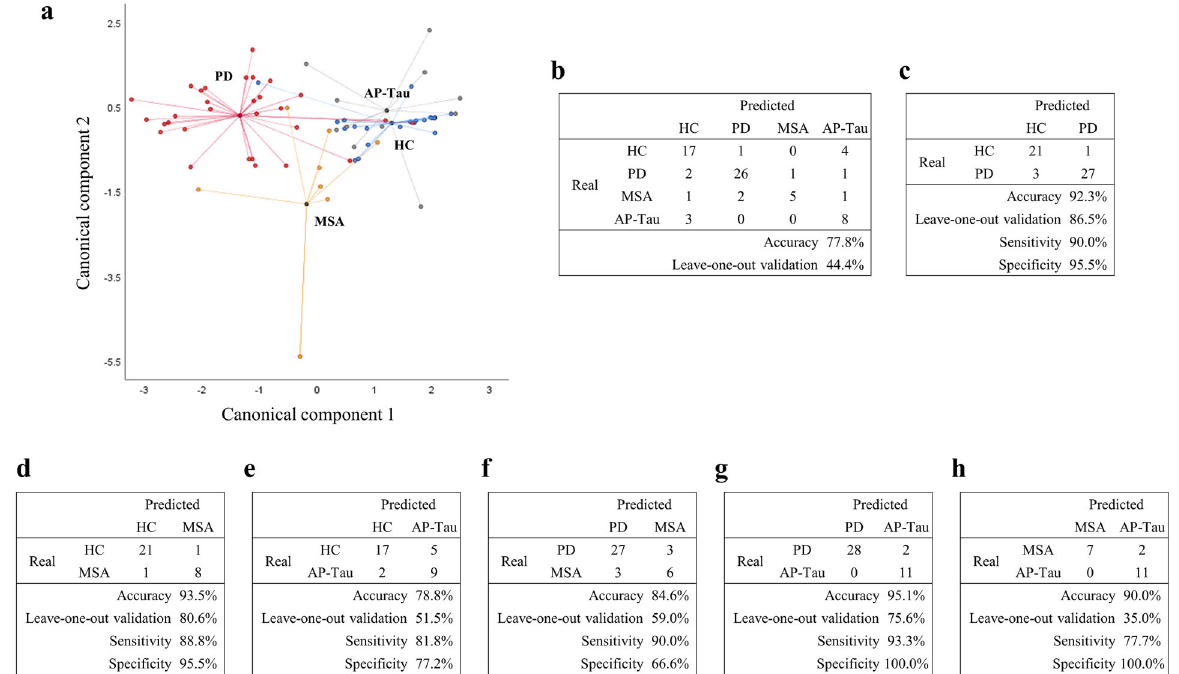
Fig. 6 Skin biopsy-derived compound marker allows strati fi cation of patients according to the diagnosis. a Canonical plot showing patients according to the diagnosis. The model was built considering the presence/absence of α Syn-PLA, P- α Syn, α Syn-5G4, and intraepidermal nerve fi ber density (IENFD) at both anatomical sites. The axes of the plot (canonical components 1 and 2) were calculated from weighted linear combinations of variables to maximize the separation between the four groups. Each subject is represented by a point. b – h Confusion matrix reporting real and predicted diagnosis, accuracy, internal validation by the leave-one-out algorithm, sensitivity, and speci fi city is reported for all groups and pairwise